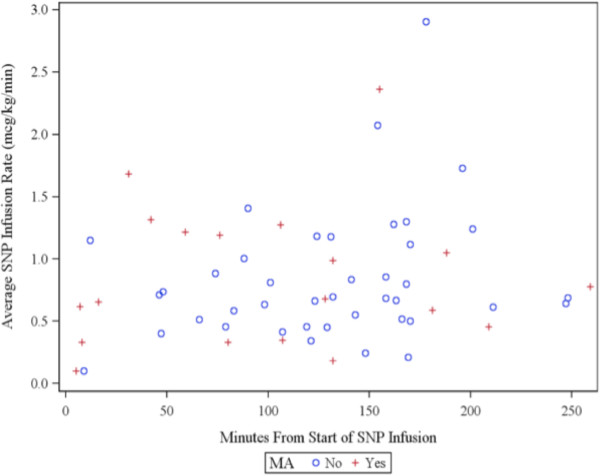
Plot of relationship between metabolic acidosis (MA) occurrence and both the duration of SNP administration and average SNP infusion rate until either MA was detected or the end of the study. Only patients in the SNP group are plotted. Patients with and without MA are plotted using a “+” and “o,” respectively.